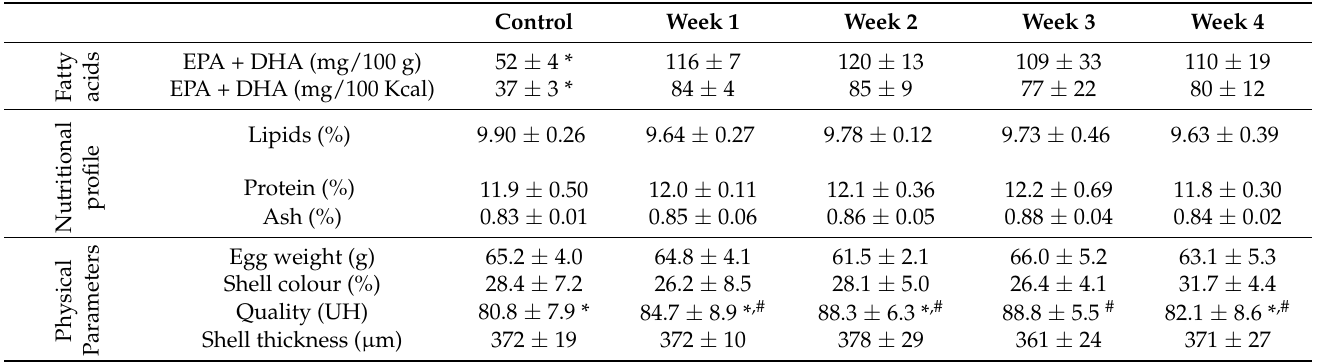
For each parameter (same row), distinct symbols (*, # ) mean statistically significant differences ( p < 0.05) between groups (N = 5 for fatty acids and nutritional profile data; N = 12 for physical parameters data). DHA—docosahexaenoic acid